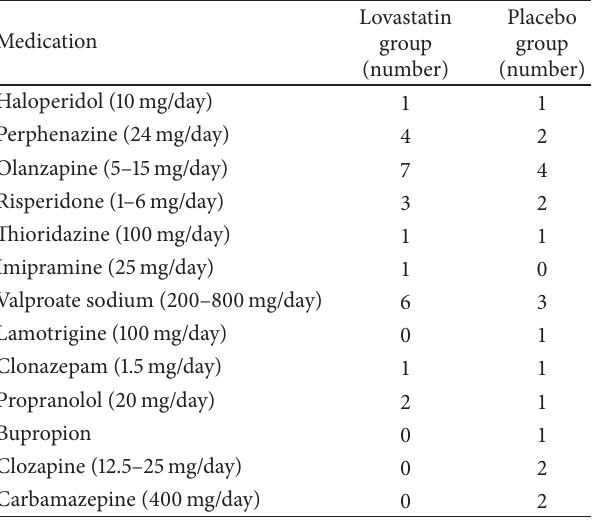
Figure 2: The changes of Young Mania Rating Scale score in the lovastatin and placebo group during this trial. Table 2: The rate and dose of concomitant medications by the groups.